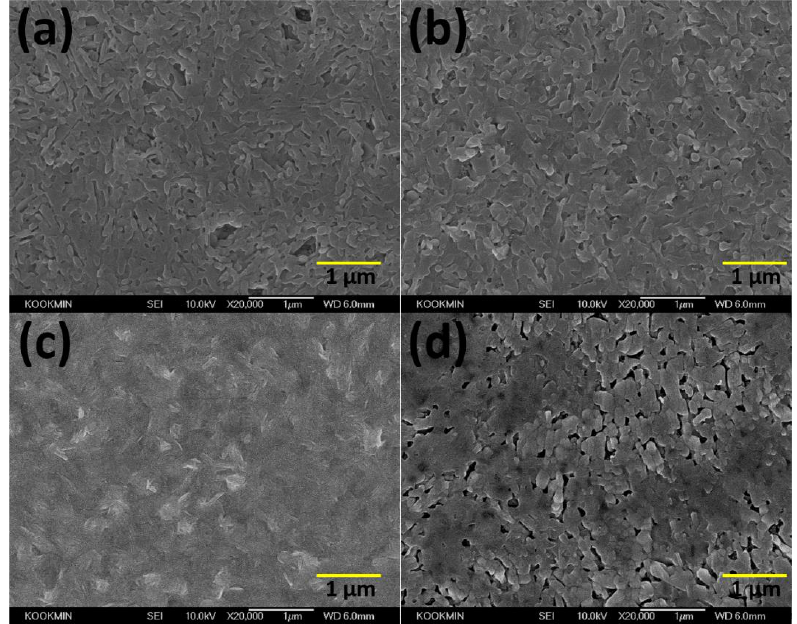
Figure 2. Surface morphology of lead halide films deposited on a meso-TiO 2 substrate at x = ( a ) 0; ( b ) 0.1; ( c ) 0.3; and ( d ) 0.5. ( b ) 0.1; ( c ) 0.3; and ( d ) 0.5.